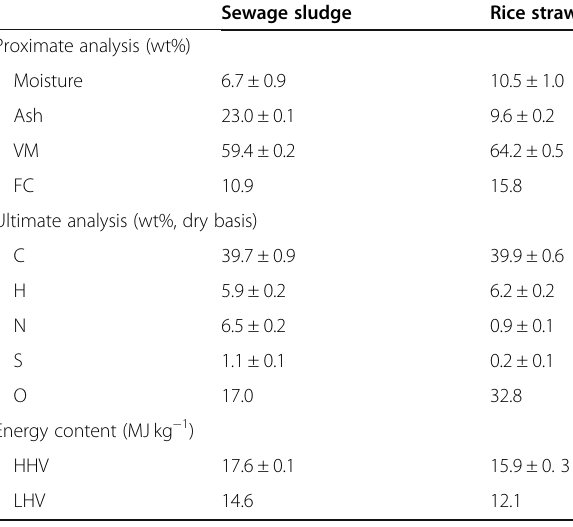
Table 1 Characteristic of tested sewage sludge and rice straw Sewage